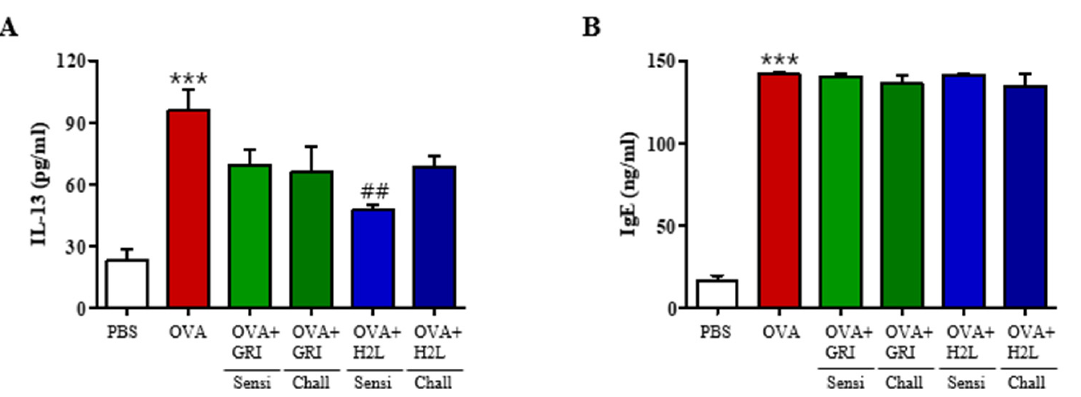
Figure 7. Effect of H2L5186303 and GRI977143 on IL-13 levels in the BALF and IgE levels in the serum. ELISA was used to measure the protein levels of ( A ) IL-13 in BALF and ( B ) IgE in serum. Results are presented as the mean ± standard error of the mean (SEM) ( n = 5). *** p < 0.001 vs. the PBS-treated group, ## p < 0.01 vs. the OVA-treated group.